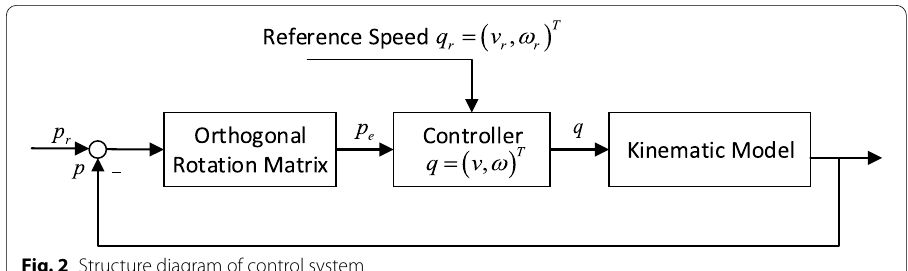
Fig. 2 Structure diagram of control